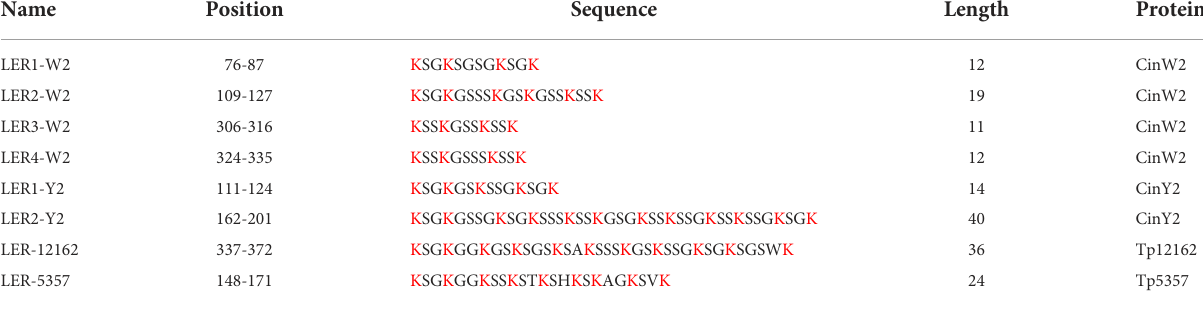
TABLE 1 Lysine-enriched regions (LERs) in the proteins studied in this work (lysine residues are in red